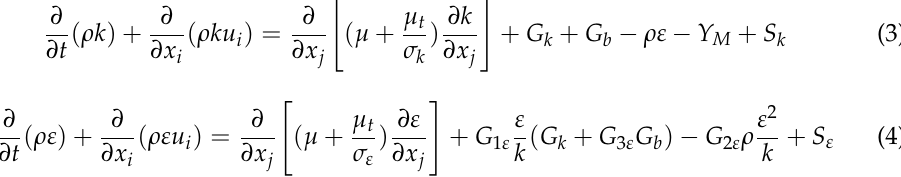
Figure 2. Phase–layer division.